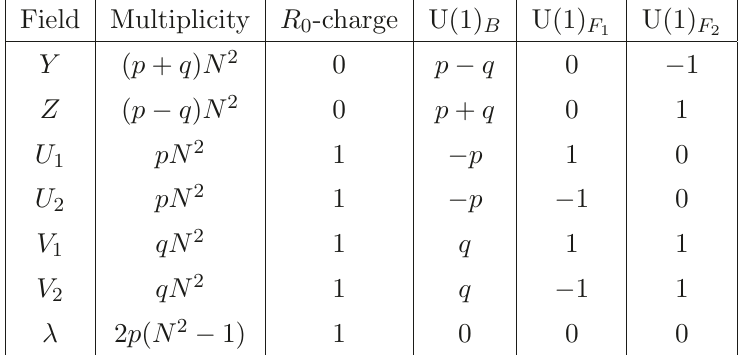
Table 1 . The field content of the Y p,q quiver